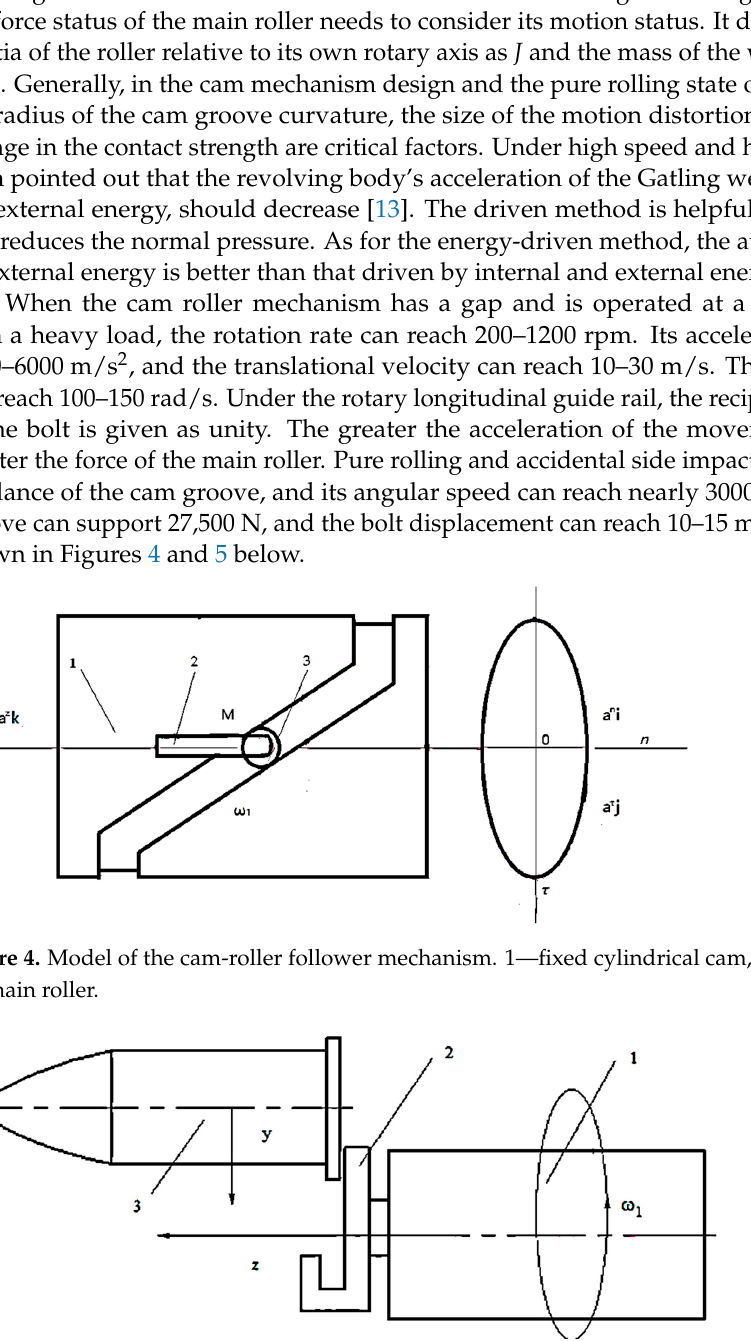
Figure 5. Bolt body model. Note: 1—bolt body, 2—bolt nose, and 3—a missile. As the cycles of the main roller slide along the cam curve slot surface, the friction condition deteriorates gradually, and the driving power consumption increases.